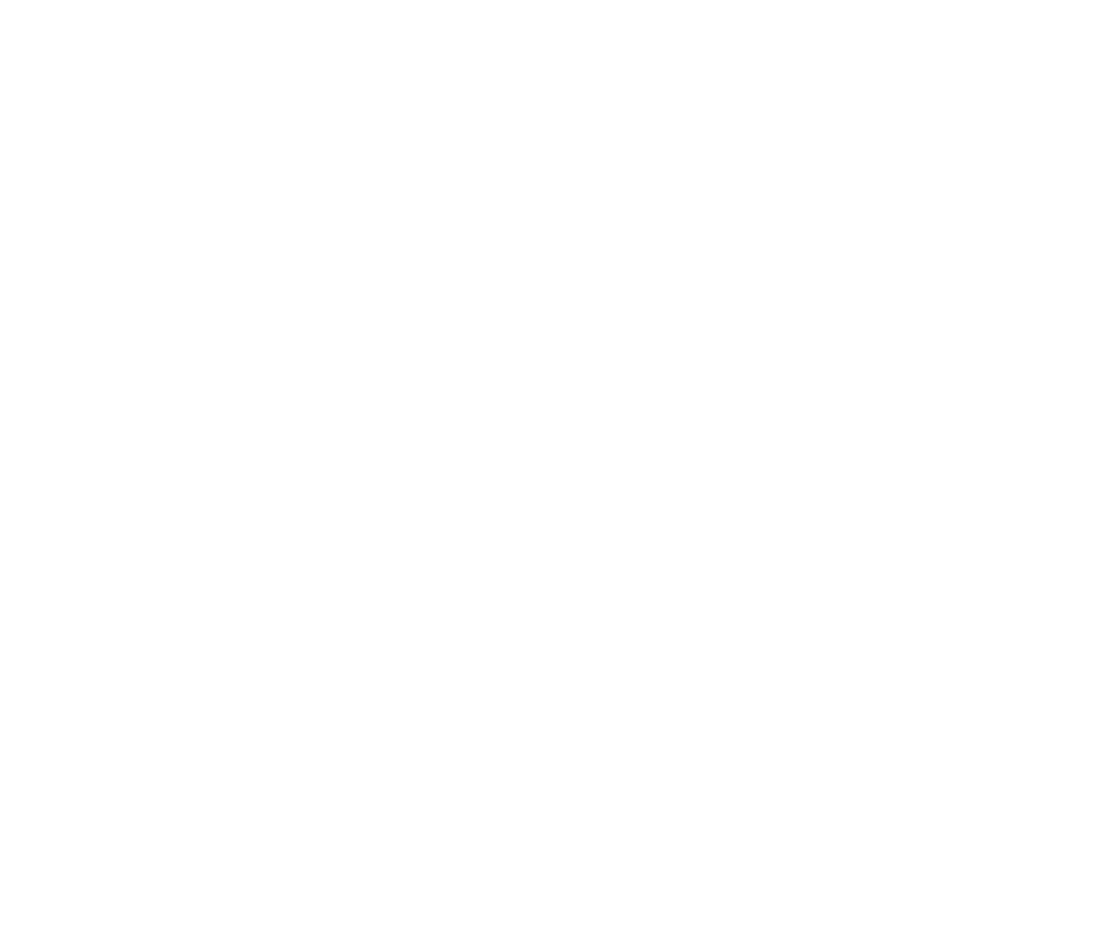
Figure 4. ( a ) Feature-wise correlation of reconstruction to reconstruction in 3D-2 cm split by reconstruction. ( b ) Segmentation to segmentation correlation based on 3D-2